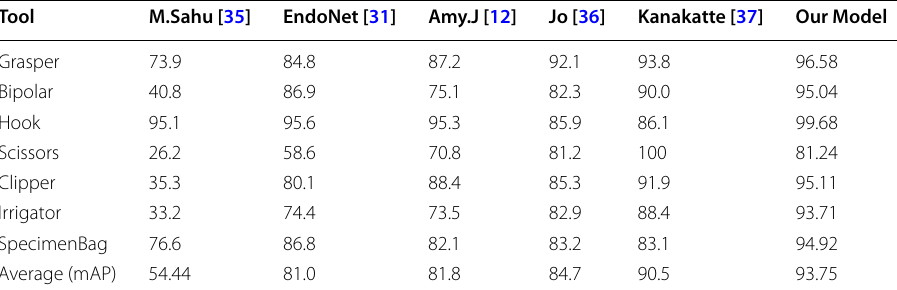
Scissors Irrigator Average